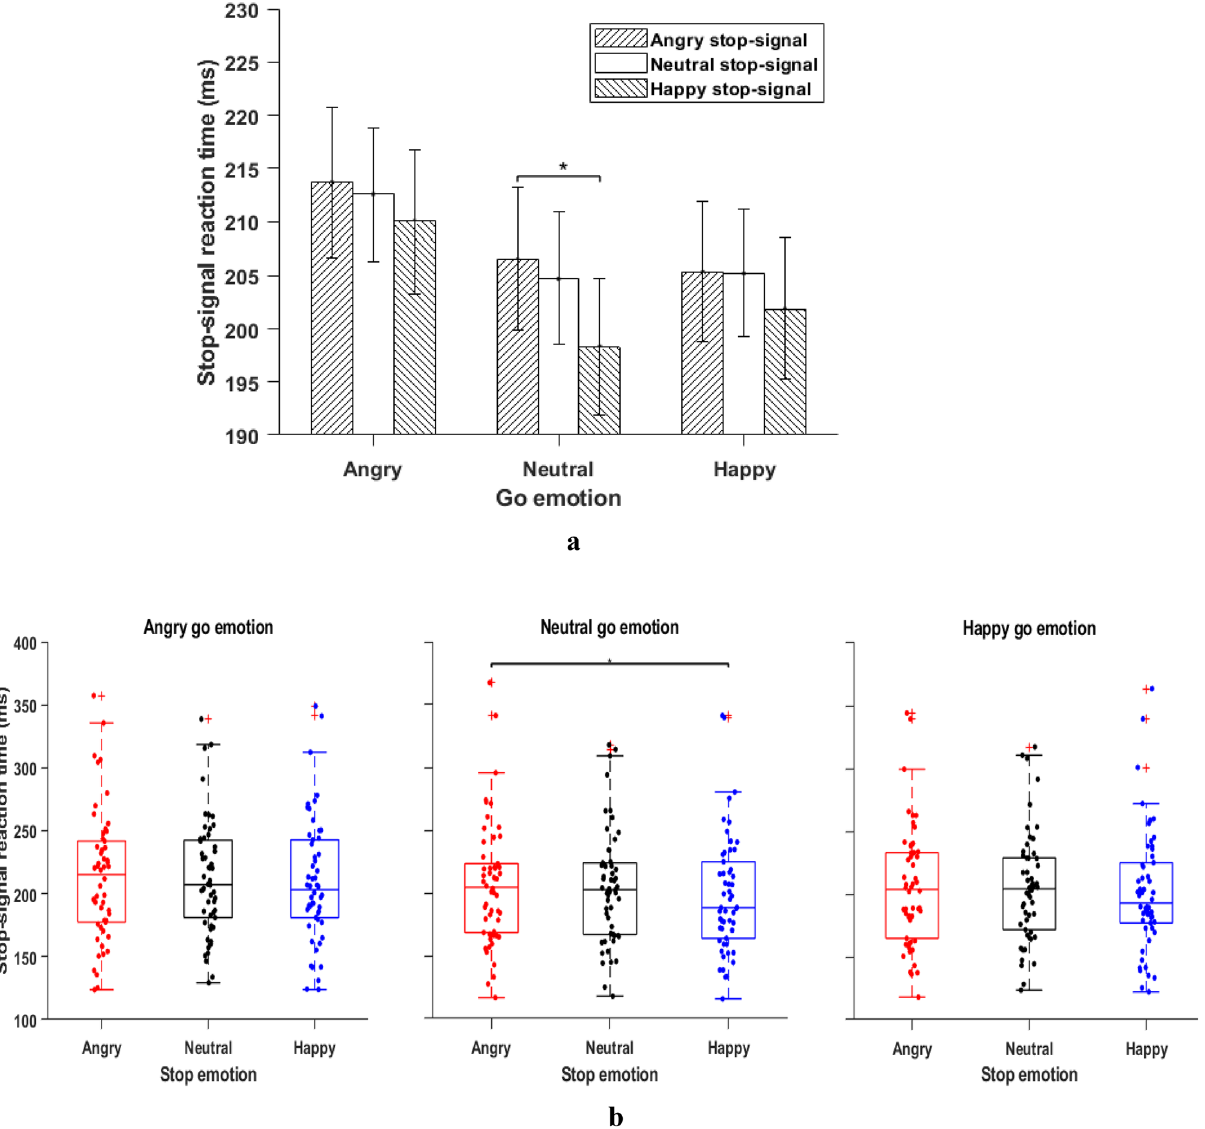
Figure 3. ( a ) Stop-Signal Reaction Time: Nine Conditions. Stop signal reaction time (SSRT) for nine conditions grouped as per the emotion of go signal (x-axis). Error bars indicate the standard error of the corresponding means. The legend shows three emotional stop signals. Under neutral go emotion, the SSRT was significantly higher for the angry face stop-signal compared to the happy face stop-signal (see text). * p < 0.05. ( b ) Box-plot distribution of a . Stop signal reaction time (SSRT) for stop-signal emotion conditions grouped across three go emotions. Under neutral go emotion, the SSRT was significantly higher for the angry face stop-signal compared to the happy face stop-signal (see text). * p <